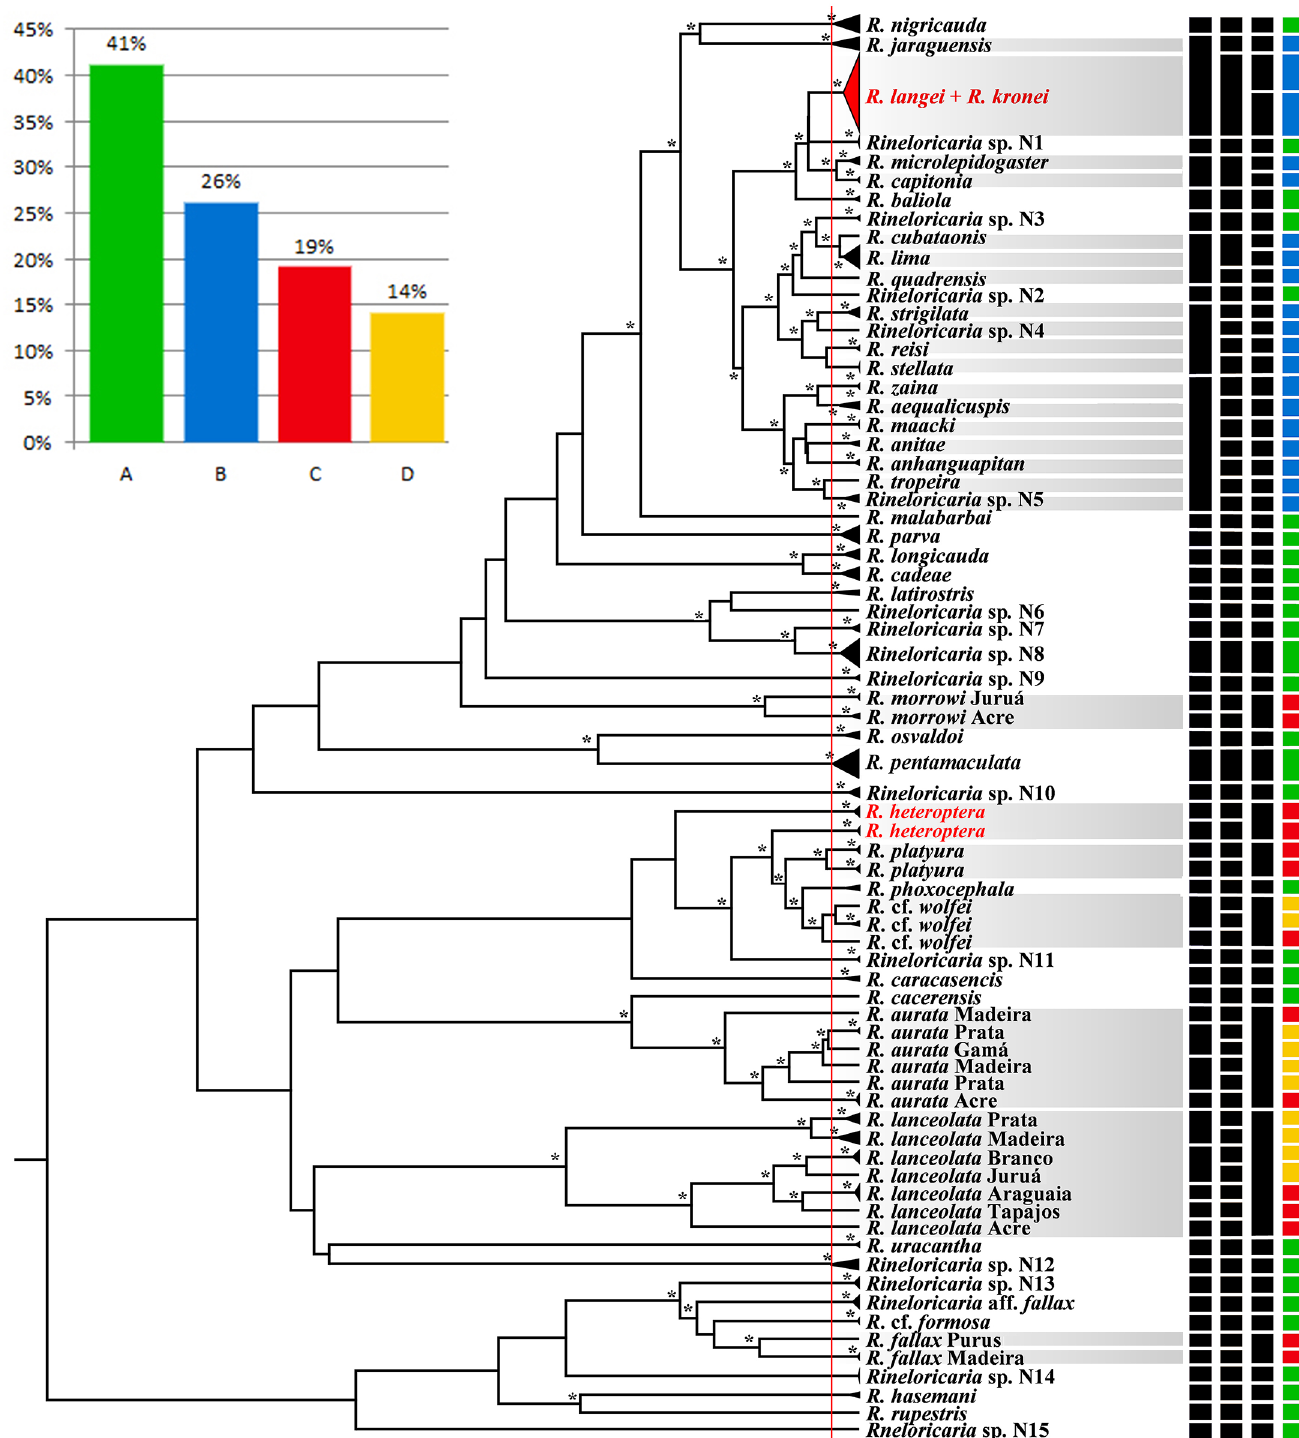
Fig 2. Bayesian phylogenetic tree of Rineloricaria obtained with COI data. The asterisks in the node branches represent a posterior probability higher than 95%. The vertical red line in the tree shows the transition point from Yule to a coalescent branching process in the analysis of all sequences, as estimated by the single-threshold model in the GMYC test. The species in the gray squares have questionable taxonomy. Red marks represent the clusters with morphospecies not reciprocally monophyletic. The first three black vertical columns represent, respectively, the status of the identification of OTUs by the BIN, GMYC and morphology criteria, while the fourth column represents the final OTUs proposed according to the criteria shown in Fig 1. The OTU color corresponds to the colors used in Fig 1 doi:10.1371/journal.pone.0135075.g002 PLOS ONE | DOI:10.1371/journal.pone.0135075 September 2,